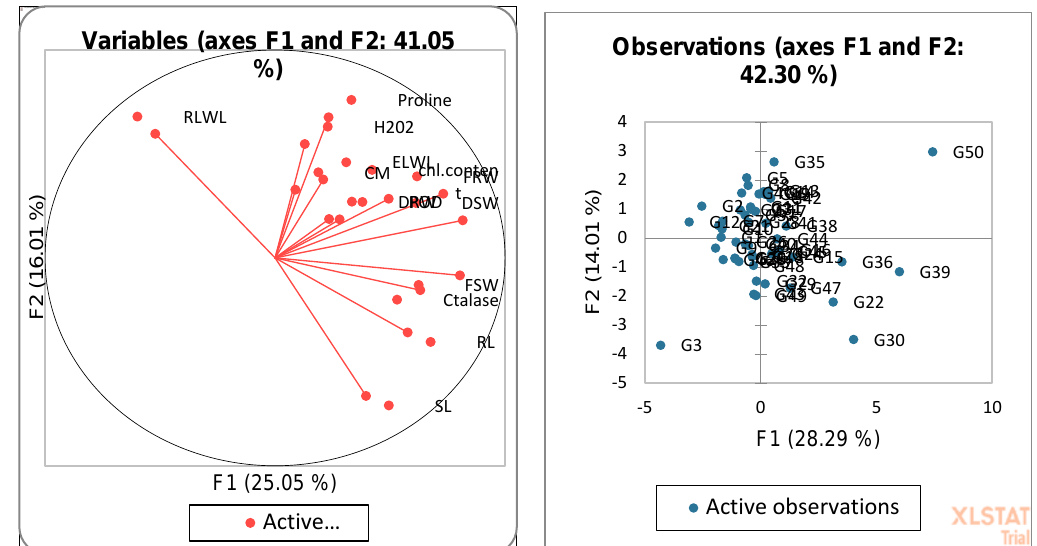
Figure 8. Biplot analysis of 50 cotton accessions for different seedlings characters grown under 50% drought level. Where RL = Root length; SL = Shoot length; FRW = Fresh root weight; FSW = Fresh shoot weight; DRW = Dry root weight, ELWL = Excised leaf water loss, RLWL = Relative leaf water loss, CMS = Cell membrane stability, Chlr = Chlorophyll content; Proline = Proline; POD = Peroxidase; H 2 O 2 = Hydrogen peroxide; CAT = catalase activity. Note: Genotype G50 “Cyto-515” (highlighted) at the top right performed best among other genotypes under a 50% stress level